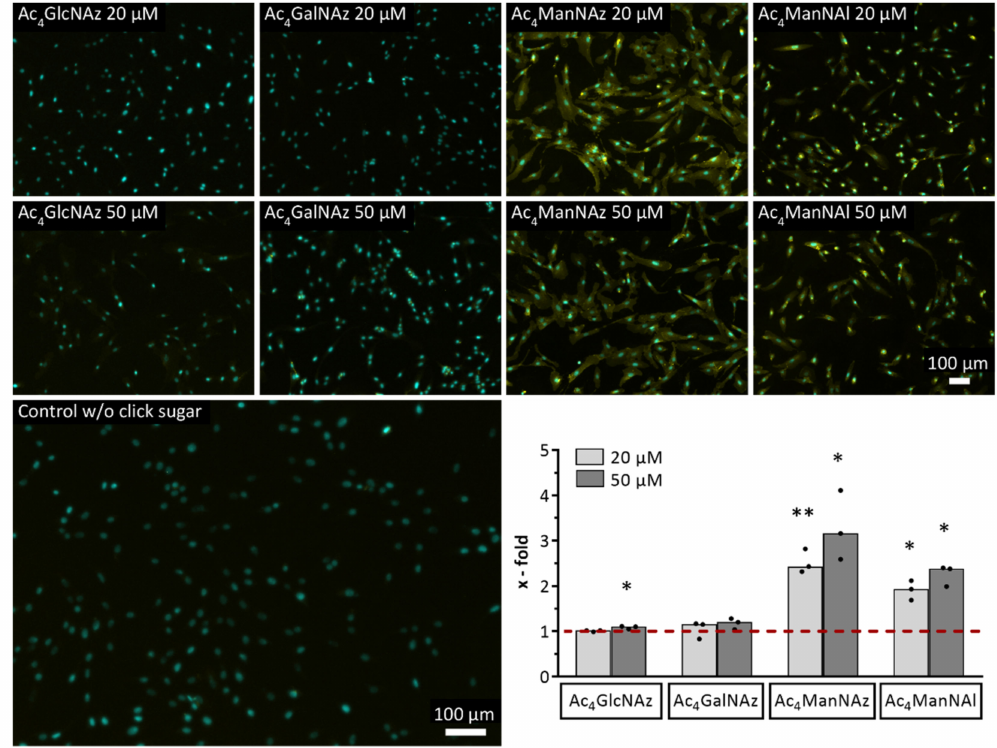
Figure 2. Incorporation of four different modified monosaccharides into the glycocalyx of hMSC-TERT after 72 h incubation. Yellow: fluorescence signal of Cy 3/5 after copper(I)-catalyzed azide-alkyne cycloaddition (CuAAC) click reaction, cyan: fluorescence signal of cell nuclei. Representative fluorescence images of three independent experiments are shown. The diagram shows the quantitative analysis of fluorescence micrographs from three independent experiments. Cy 3/5 fluorescence signal as a mean grey value is depicted relative to the DMSO-treated control (dashed line). Datasets (median with individual values) were tested using two-tailed paired t -test for significance ( p < 0.05 depicted as *, p < 0.01 depicted as